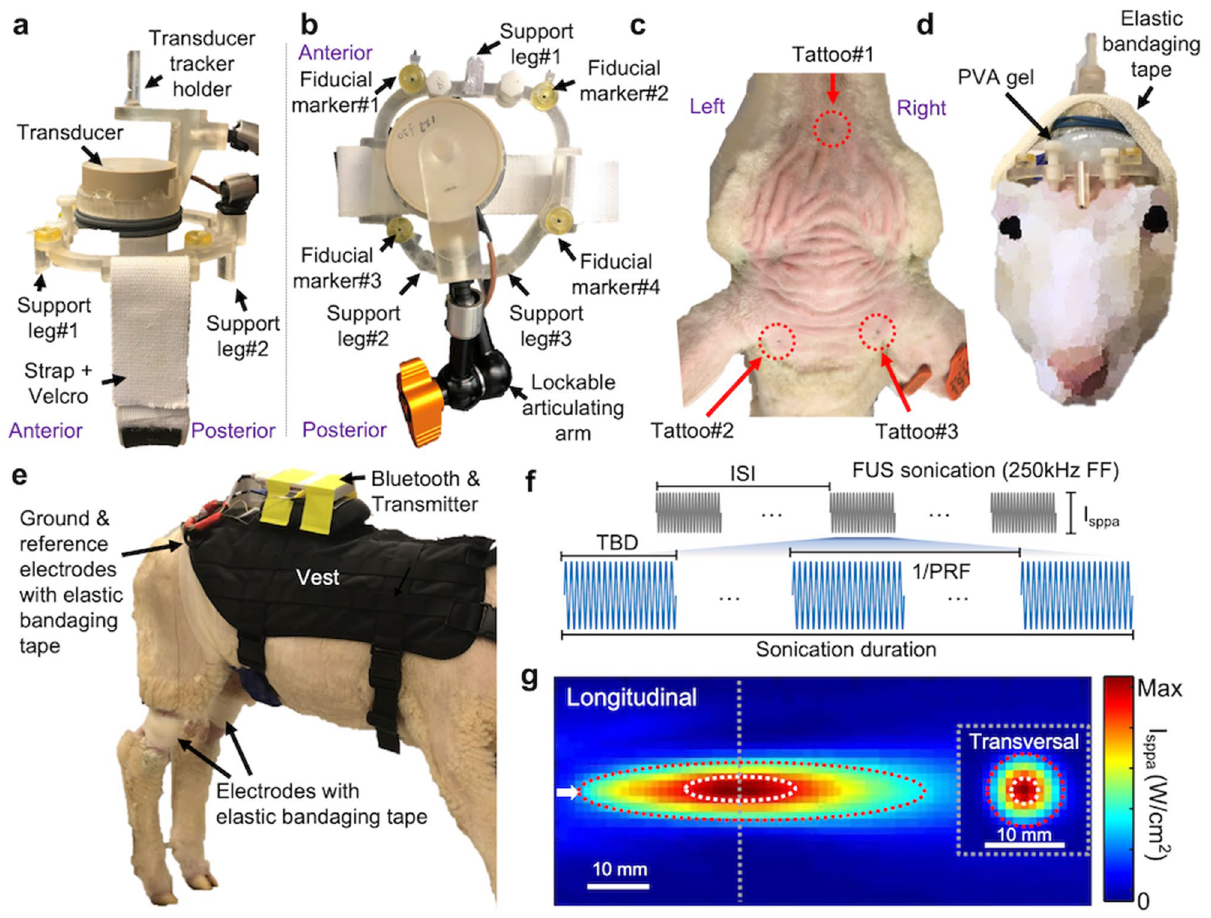
Figure 1. Schematics of the experimental setup. Wearable FUS headgear viewed (a) from the side and ( b ) from the top. ( c ) Exemplary tattoo locations on the sheep’s scalp, which were used for reproducible positioning of the headgear. ( d ) An illustration of the headgear with the acoustic-coupling polyvinyl alcohol (PVA) hydrogel worn by sheep (secured with elastic bandaging tape). ( e ) An experimental setup for EMG acquisition. A vest was used to attach a telemetry EMG Bluetooth transmitter and preamplifier. The ground and reference electrodes were placed on the back, and an electrode was placed on the gastrocnemii of each hind limb. All electrodes were secured using elastic tape. ( f ) An illustration of acoustic parameters. ( g ) An acoustic intensity profile across the longitudinal and transversal planes (dotted gray line). Dotted white lines depict the regions of 90%-maximum of the intensity whereas dotted red lines depict the regions of full-width at half-maximum of the intensity. The white arrow represents the sonication direction. FF, fundamental frequency; I sppa , spatial-peak pulse-average acoustic intensity; ISI, inter-stimulus interval; PRF, pulse repetition frequency; TBD, tone-burst